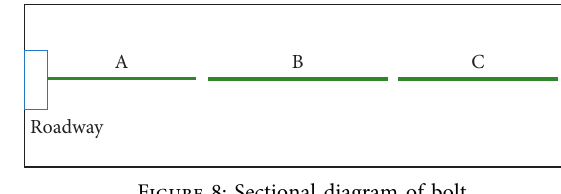
Figure 8: Sectional diagram of